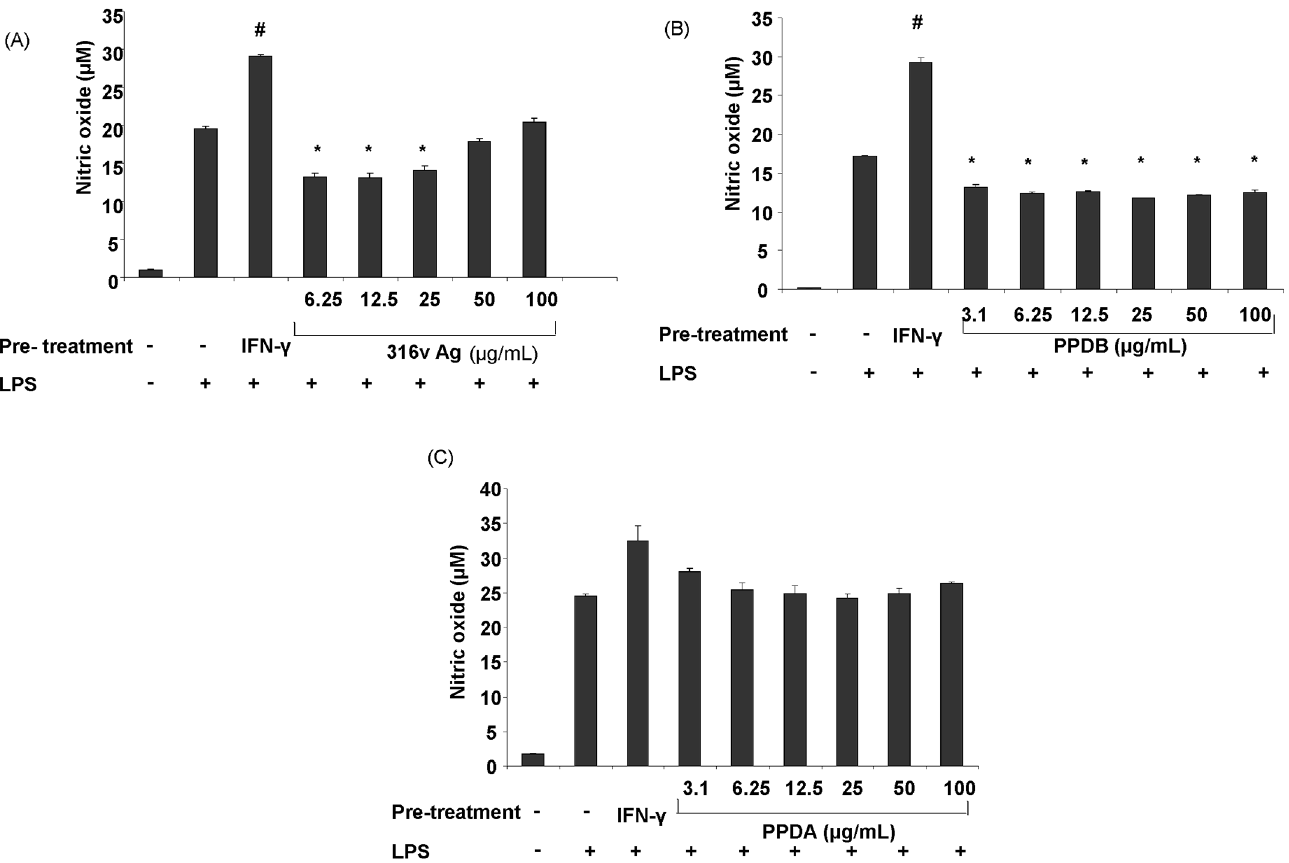
Fig 3. Suppression of macrophage nitric oxide production by pre-treatment with mycobacterial antigens. RAW 264.7 cells pre-treatedwith 316v (A), PPDB (B), PPDA (C) (6.25 to 100 μ g/mL) or IFN- γ (100 ng/mL) concentration for one hour followedby incubationwith LPS (25 ng/mL). Nitric oxide was determined in supernatantsharvestedat 48 h post-incubation. Data are the mean plus standard error of the means of five replicates from two independent experiments. * denotesa significantdifference ( P (cid:20) 0.05) betweenthe LPS inducednitric oxide productionwith and without antigen pre-treatment. # denotesa significantdifference ( P (cid:20) 0.05) in LPS inducednitric oxide productionafter IFN- γ pre-treatment comparedto the group without IFN- γ pre-treatment.